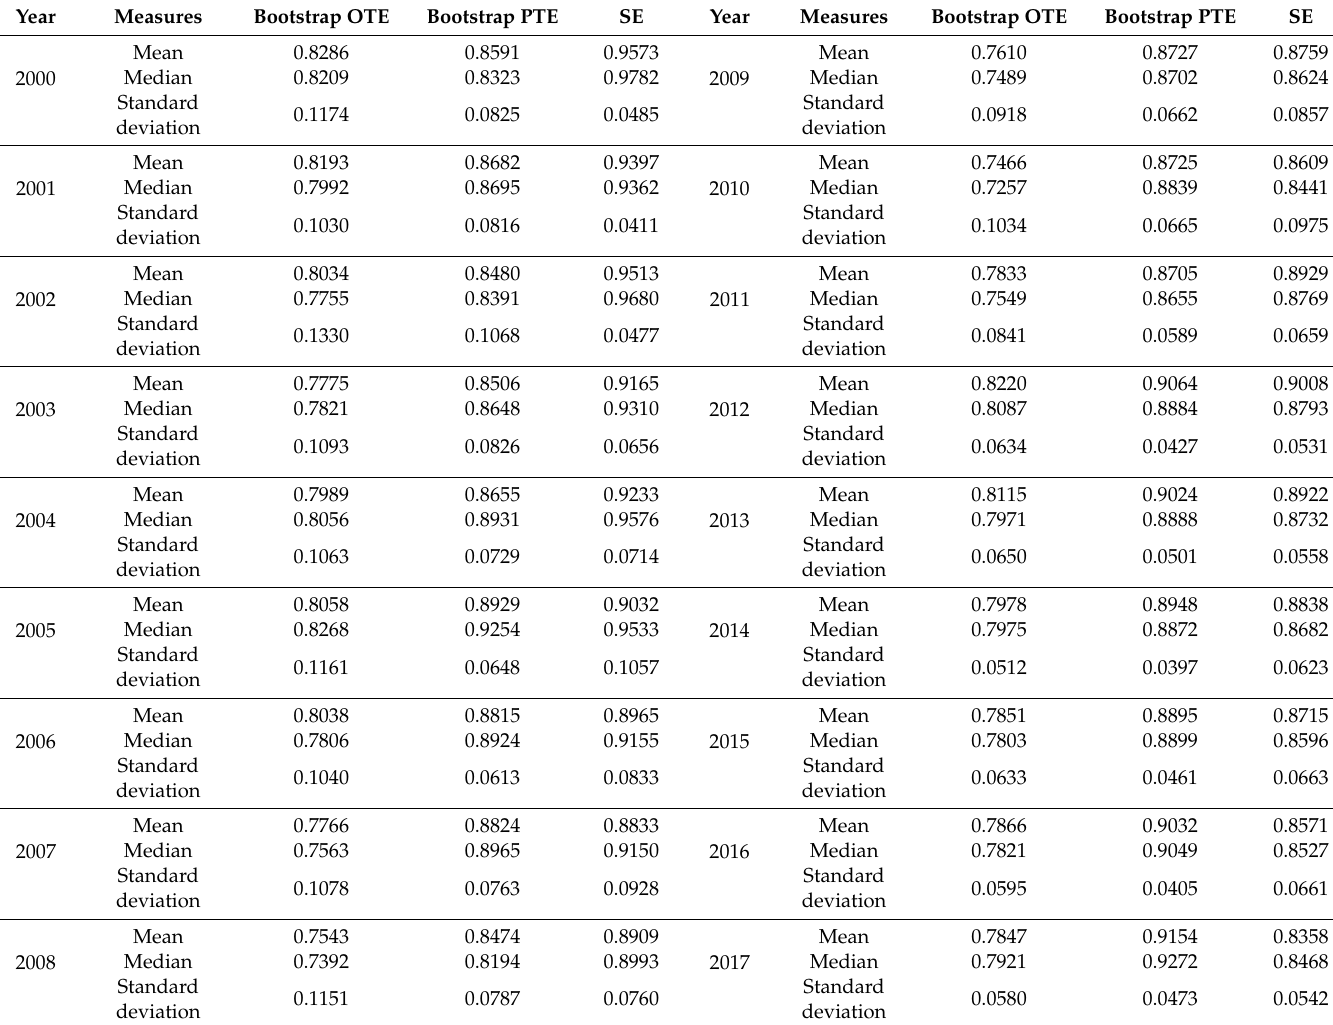
Table 3. Annual bootstrap OTE, bootstrap PTE, and the SE for the second